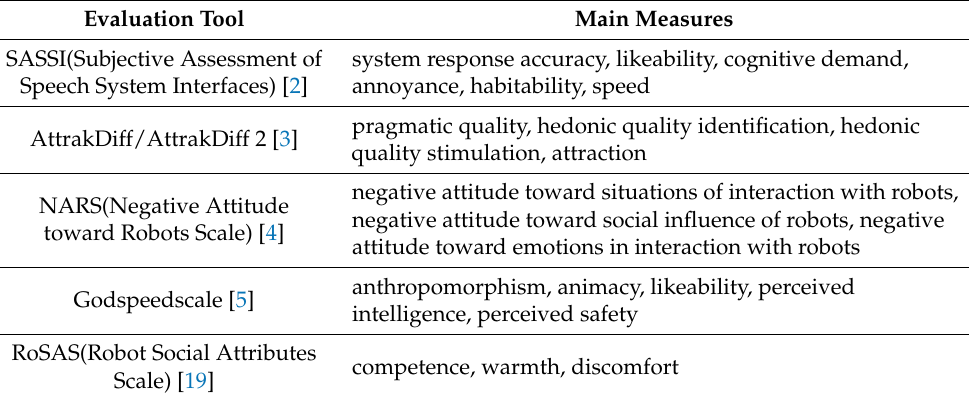
Table 3. Evaluation tools and main